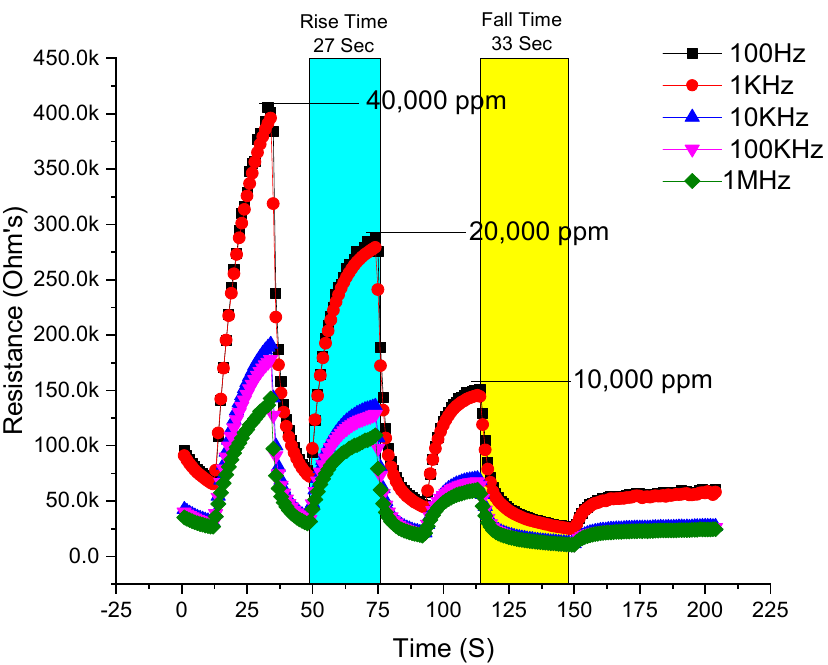
Figure 9. Response (rise of the curve) and recovery (fall of the curve) of the ammonia sensor.